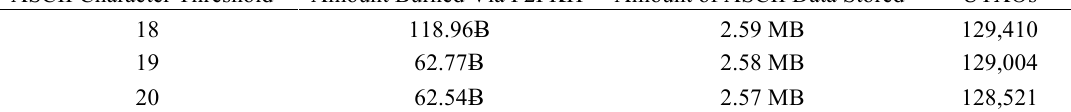
Table 1. BTC ( Ƀ ) burned storing ASCII in P2FKH